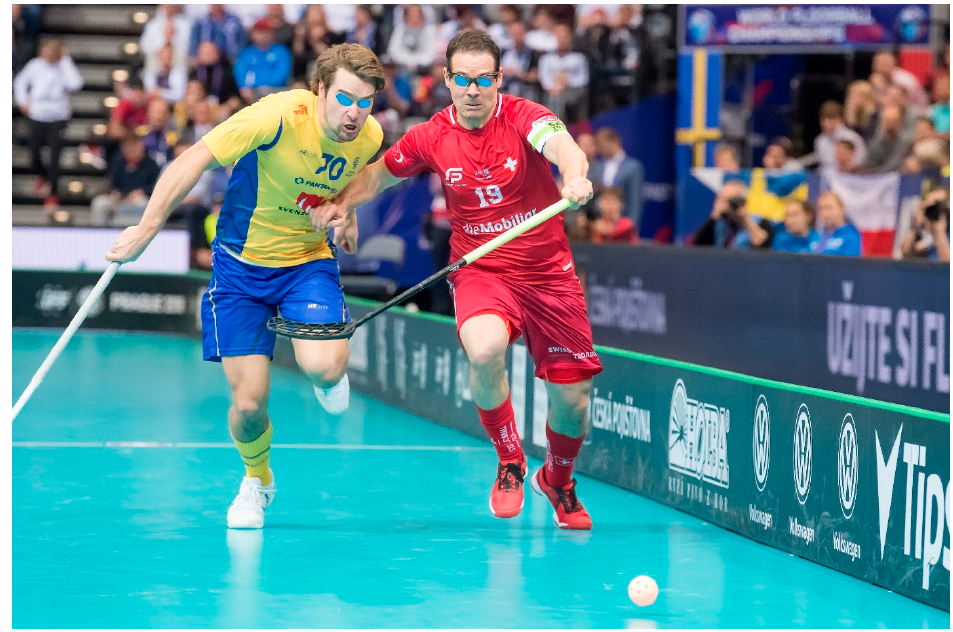
Figure 5. Protective floorball glasses (Photograph Fabian